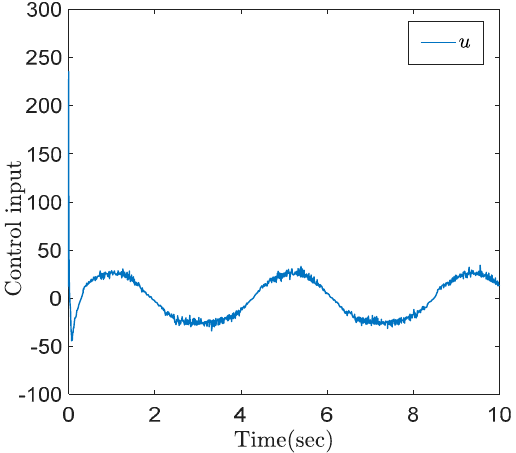
Figure 7. Estimated parameters ˆ ε i for i = 1,2,3.